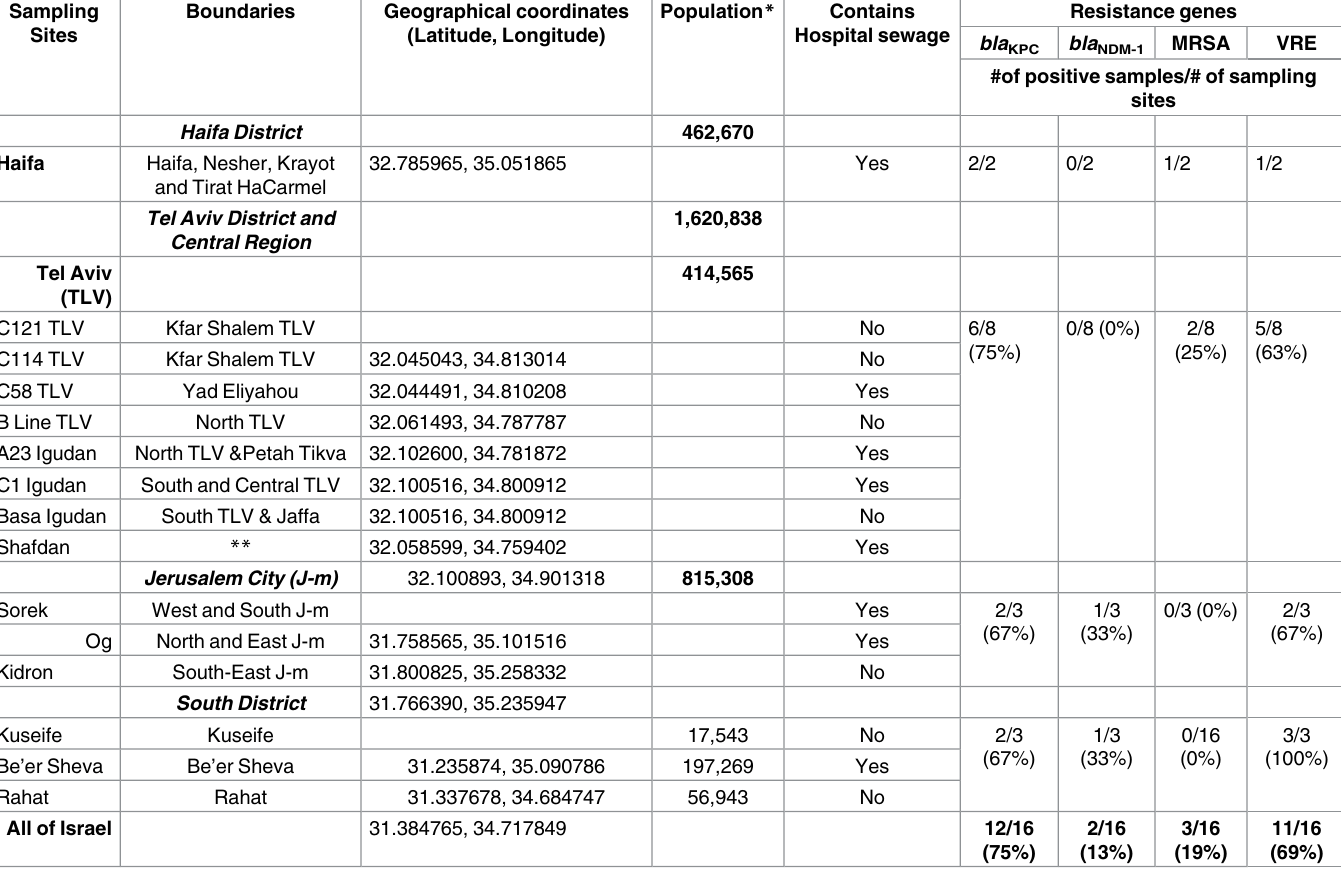
Table 1. Sampling sites information. Sampling